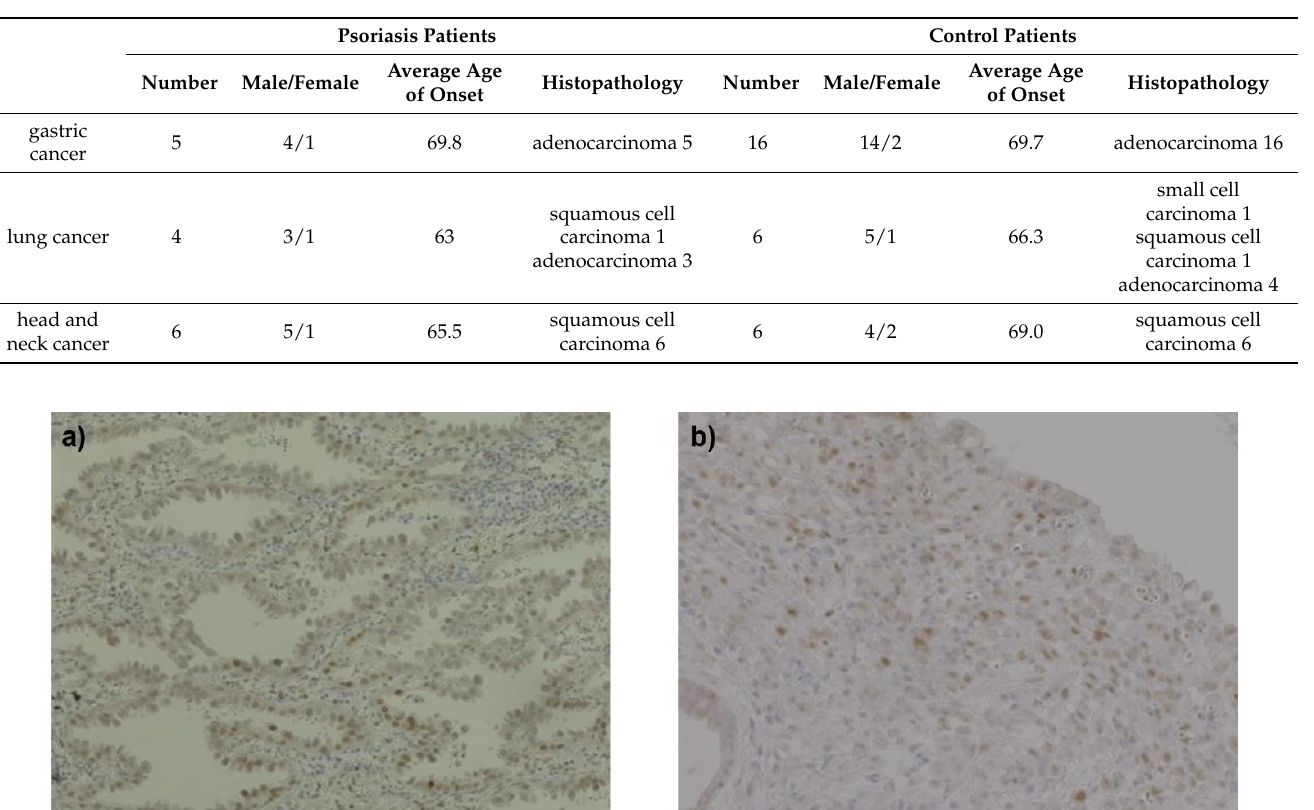
Figure 1. Staining images of phosphorylated STAT3 in cancer cells. ( a ) Expression of phosphorylated STAT3 in lung cancer developed by a control patient (score 5.33), scale bar=50 μm. ( b ) Expression of phosphorylated STAT3 in gastric cancer developed by a psoriasis patient (score 4), scale bar=50 μm. ( c ) Expression of phosphorylated STAT3 in gastric cancer developed by a psoriasis patient (score 3.33), scale bar=50 μm. ( d ) Expression of phosphorylated STAT3 in gastric cancer developed by a control patient (score 0), scale bar=100 μm 4. Discussion Many studies have shown that moderate to severe psoriasis are associated with comorbidities, such as cardiovascular disease, hypertension, metabolic syndrome, and psychiatric disorders. Cancer remains a matter of debate. Some cancers present no increased risk, but most studies have demonstrated the association of psoriasis with higher risks for cancer [19,20]. A recent meta-analysis in 2020 concluded that patients with psoriasis appear to have a slightly increased risk of cancer, particularly of keratinocyte cancer, lymphomas, lung cancer, and bladder cancer [21]. A systematic review in 2019 also showed that psoriasis was associated with an increased risk of overall cancer, as well as in site-specific cancers of the colon, colorectal, kidney, laryngeal, liver, lymphoma, keratinocyte, esophageal, oral cavity, and pancreatic cancer [20]. Our study demonstrated that there was no difference in the prevalence of cancer in psoriasis patients compared to eczema patients, but the frequency of patients with multiple cancers was significantly higher in the psoriasis group than in the eczema group, although the limitations of this study include the small sample size at a single institution and the fact that the histological type and grade of cancer were not consistent with those of the control group. Furthermore, the number of patients with sufficient samples at our hospital was limited because some patients underwent surgery at other institutions or did not undergo resection after diagnosis by biopsy. In order to compare psoriasis which is a Th17-balanced inflammatory